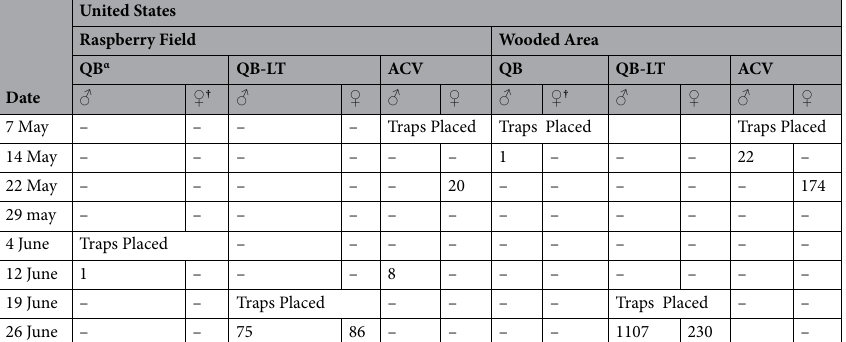
Table 1. Week, date, and number of males and females of first capture of D. suzukii by different traps within a raspberry field and a nearby wooded area in the United States in 2019. QB are sticky traps baited with USDA QB, QB-LT are liquid Victor traps baited with USDA QB, and ACV are traps baited with apple cider vinegar. † (On female symbol in table): Due to the difficulty in detecting female SWD on sticky traps female counts were not performed. α dry sticky traps in the USA could not be placed into field until raspberry bushes were tall enough to allow for them to